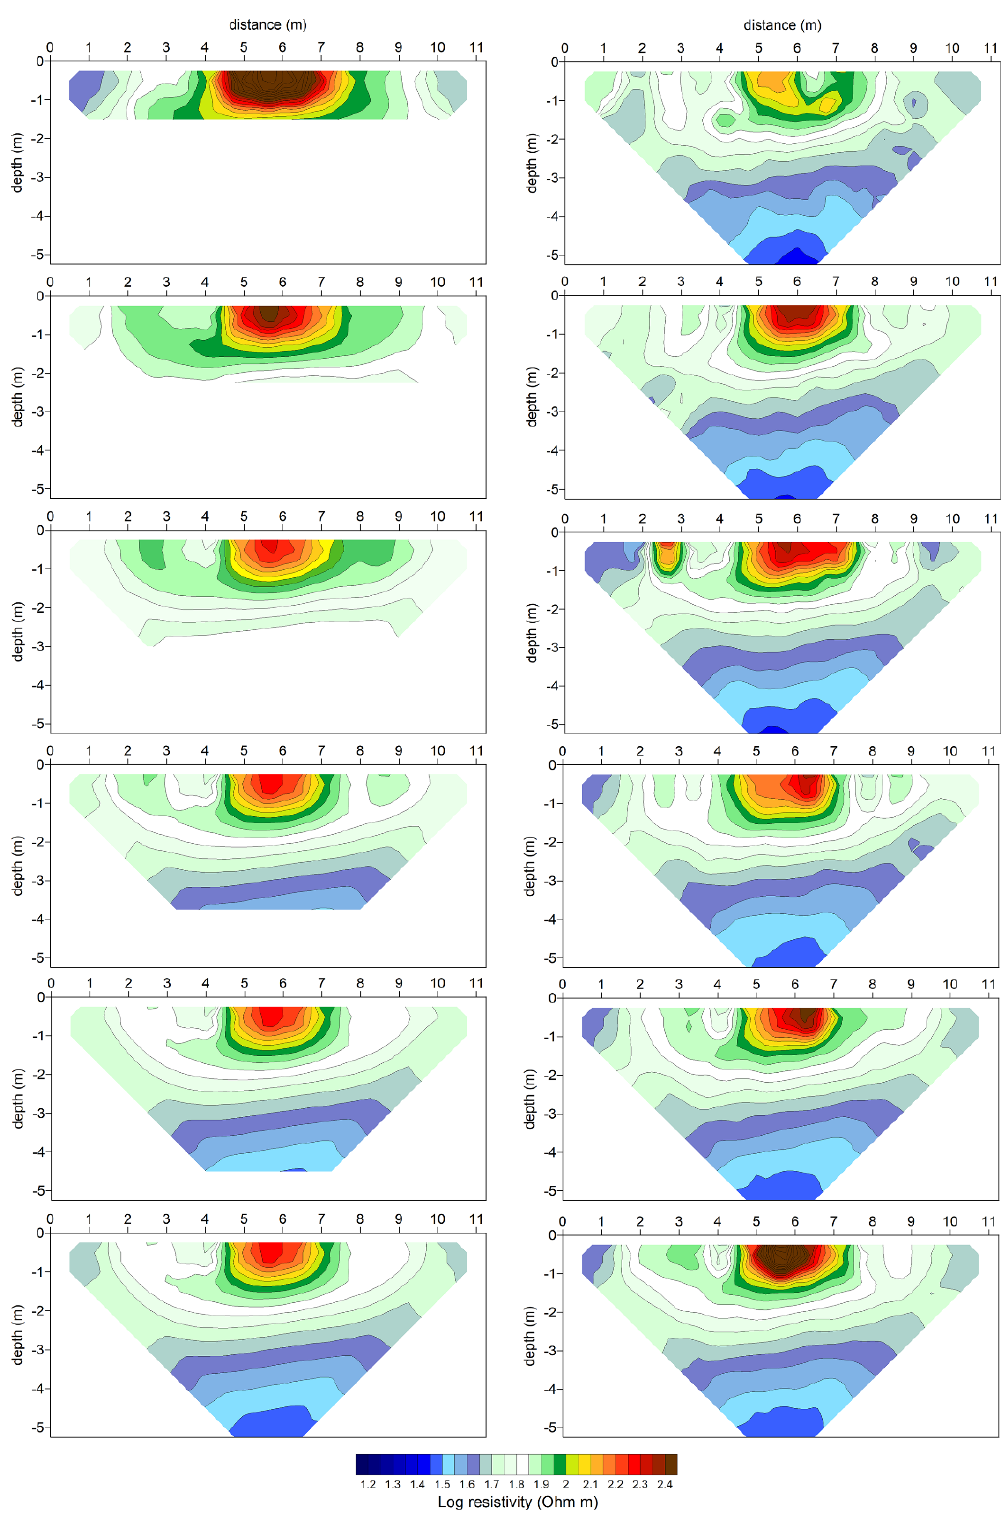
Figure 11. Extension of PERTI for the field example of Figure 10 showing progressive N q tests by vertical scanning ( left column ) and random N q tests from the N ‐ dimensional pseudosection space ( right column ).